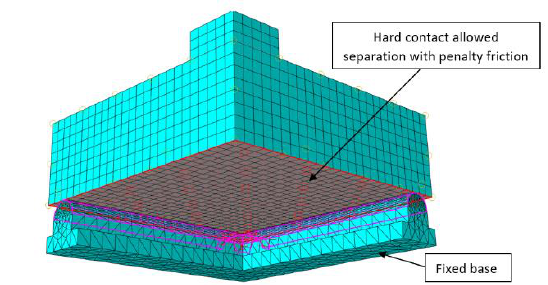
Figure 13. Numerical model of NC slab.